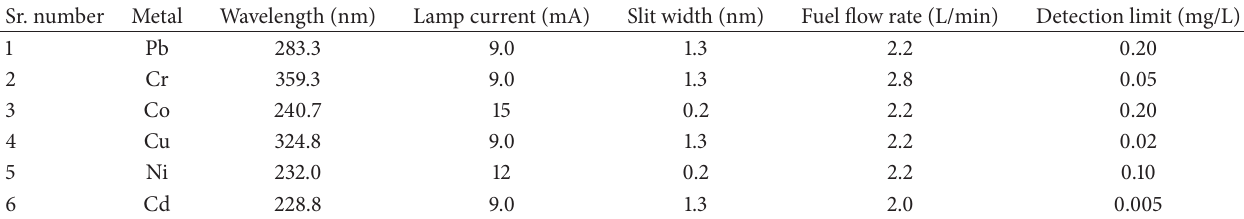
Table 1: Analytical parameters for the estimation of selected metals by